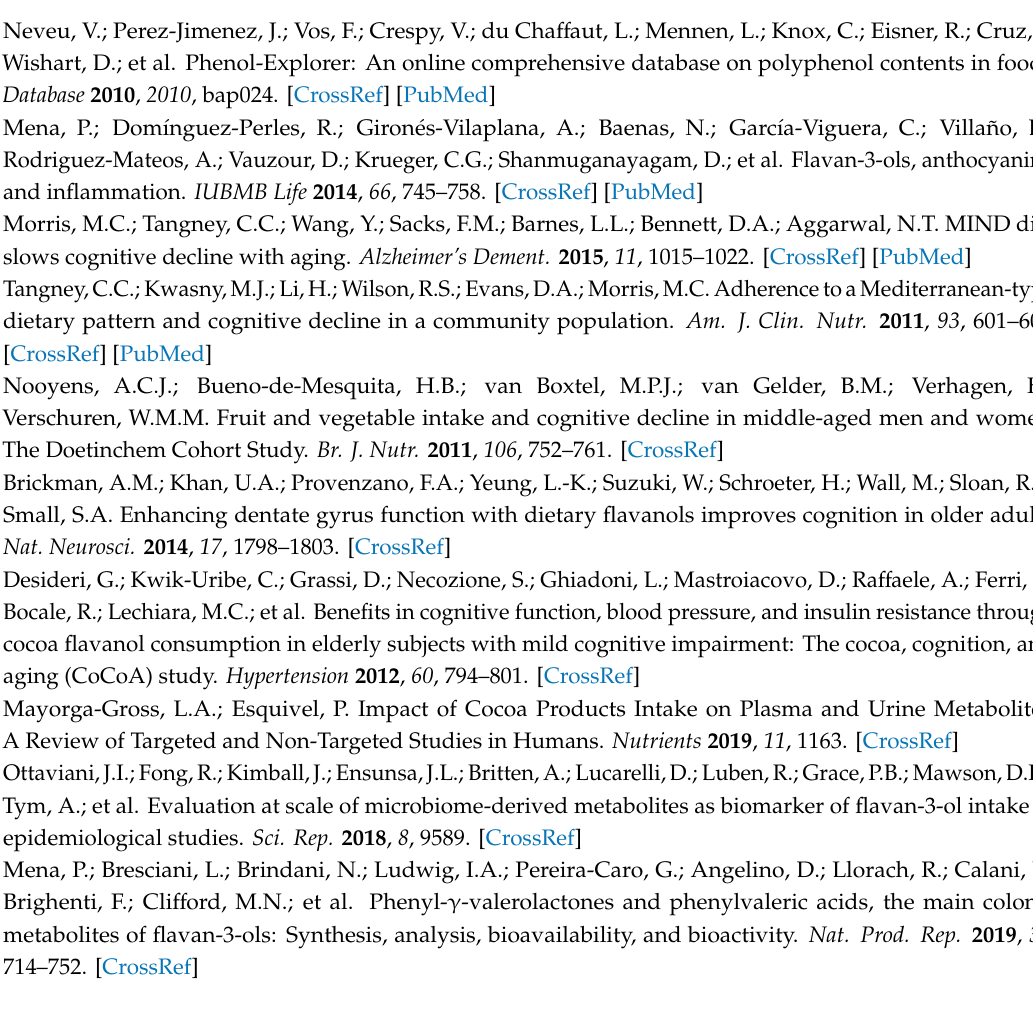
Table S1: List of molecular descriptors relevant, based upon the literature, for #BBBscore together with the respective range, Table S2: Number of #stars defined by QikProp for all molecules evaluated, Table S3: Predicted values for the 12 molecular descriptors selected for evaluation in the #BBBscore for all